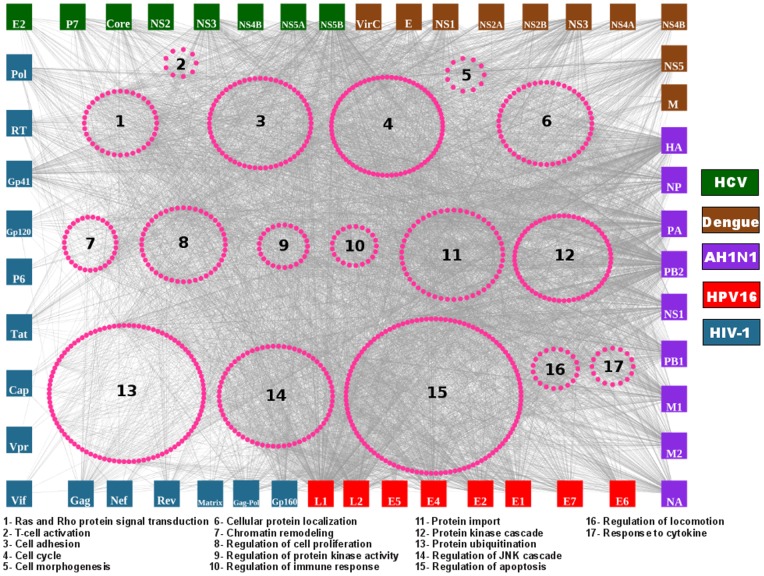
The viral-human interactome for five clinically important viruses.The nodes with squared shape represent to the viral proteins. Nodes with circular shape and magenta color represent the human proteins. The numbers represent to over-represent pathways within the viral-human interactome.